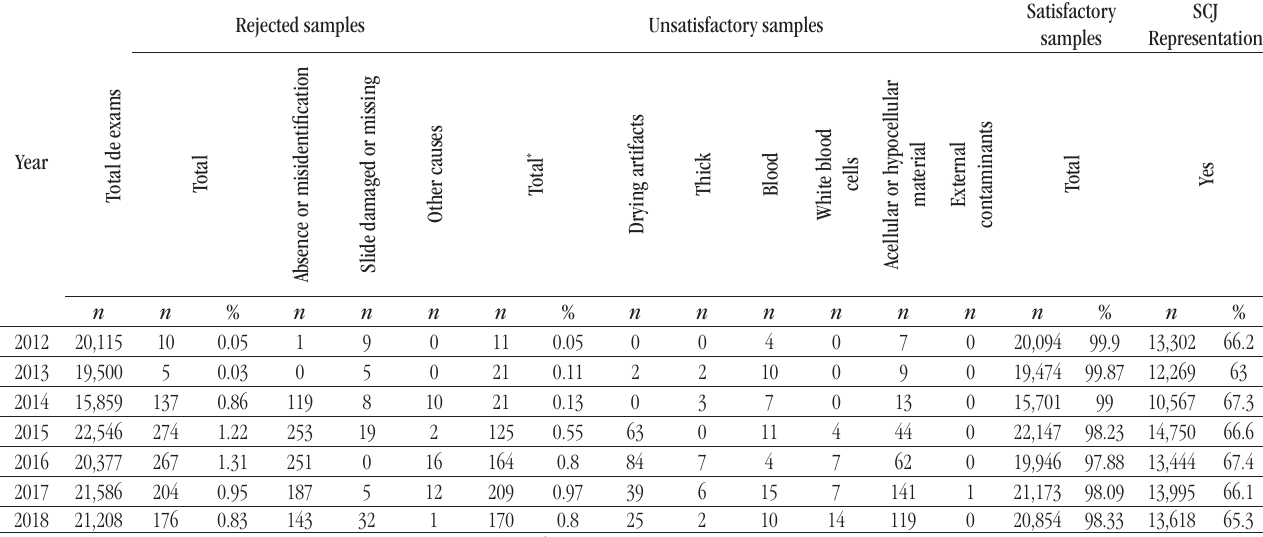
table 1 – Adequacy of the sample of cervical cytopathological exams, according to the recommendations of the MH, underwent by the female population using SUS in the municipality of Cascavel, Paraná, between 2012 and 2018